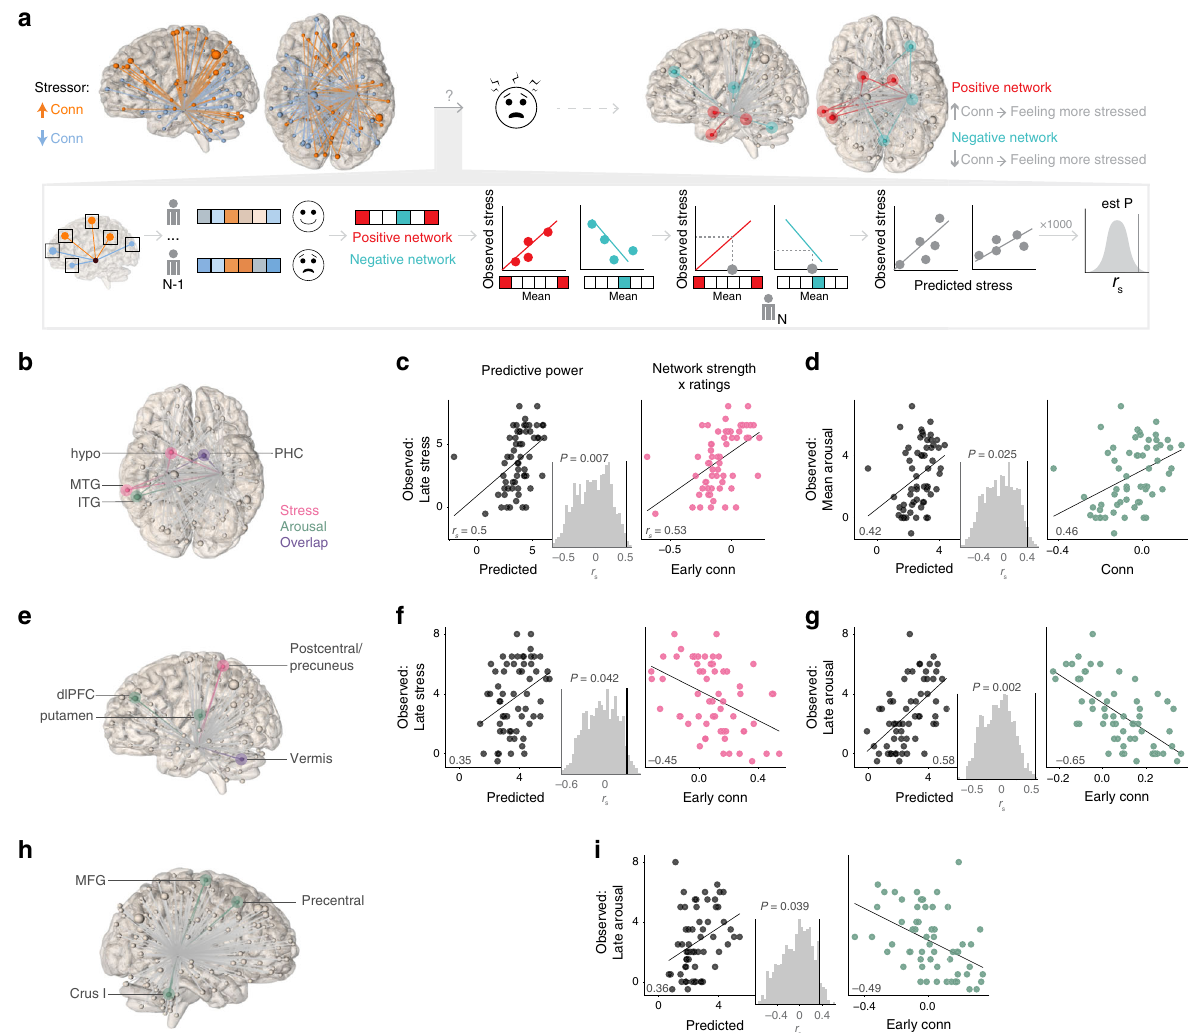
Fig. 2 Stressor-induced hippocampal connectivity networks predict feelings of stress. a Schematic of seed connectome-based predictive model (sCPM) analysis and summary of predictive networks. The goal of this analysis was to determine whether stressor-modulated hippocampal connectivity could predict feelings of stress and, if so, to identify the clusters that were part of positive (predict feeling more stressed) and negative (predict feeling less stressed) networks. We used leave-one-out cross-validation to determine which clusters correlated (positively and negatively) with feelings of stress across N-1 participants, and used these linear models to predict feelings of stress in left-out participant N . b – g Hippocampal functional connectivity networks predict feelings of stress. b – d Positive networks separated by whether they predicted ratings of stress (pink) or arousal (green). b Anatomical distribution of positive network. Clusters that predicted both stress and arousal shown in purple. c , d Summary of network performance. Left, predictive power; Spearman ’ s correlation ( r s ) of model-predicted with observed ratings. Histogram shows distribution of correlation values from 1000 iterations of randomly-shuf fl ed feelings of stress used to nonparametrically determine P values. Right, correlation between overlap network strength (i.e., mean of clusters selected on every leave-one-out iteration) and observed ratings. e – g Negative networks. As in ( b ), clusters that predicted both stress and arousal are shown in purple. h , i Posterior hippocampal functional connectivity network predicting lower arousal ratings. Source data for network performance are provided as a Source Data fi